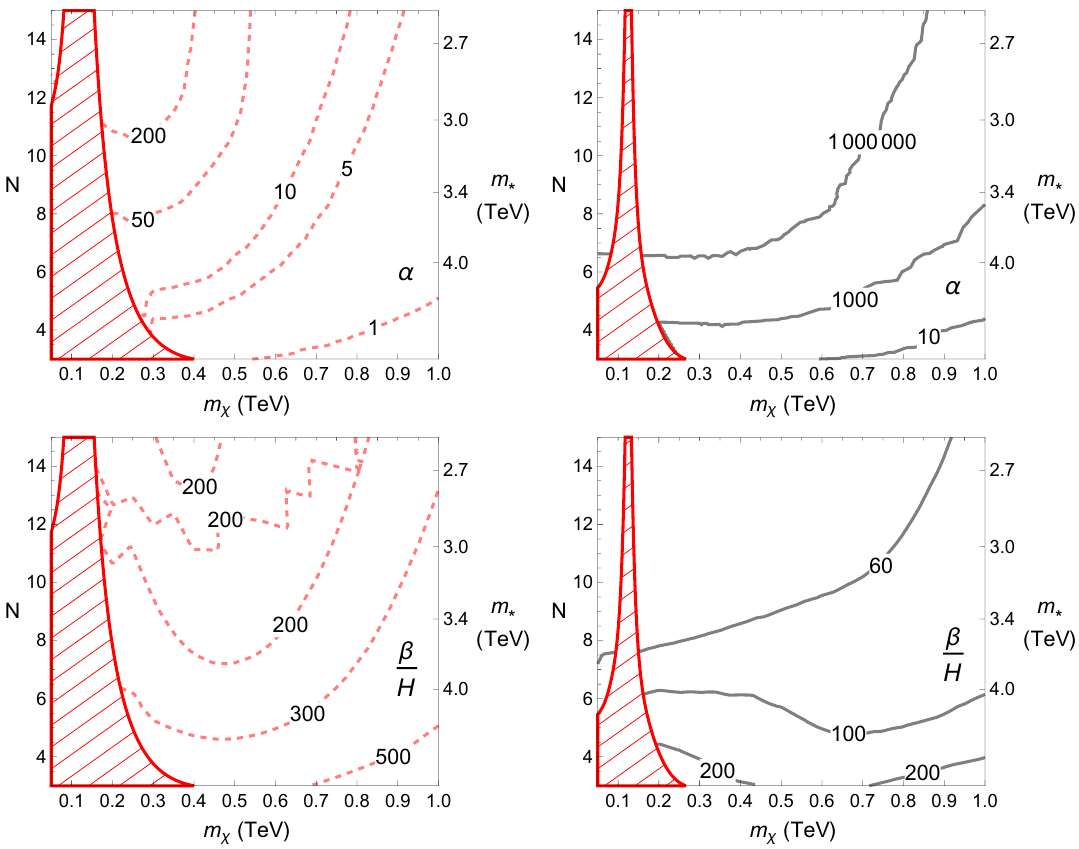
Figure 16 . The parameters (cid:11) (upper panels) and (cid:12)=H (lower panels) which determine the GW signal as a function of m (cid:31) and N for a meson-like dilaton (left panels; red dashed) and a glueball- like dilaton (right panels; black solid). A signal in the LISA band is expected for 1 . (cid:12)=H . 10 4 and (cid:11) & 0 : 1 [84, 85]. In the red dashed region, there is no phenomenologically viable electroweak